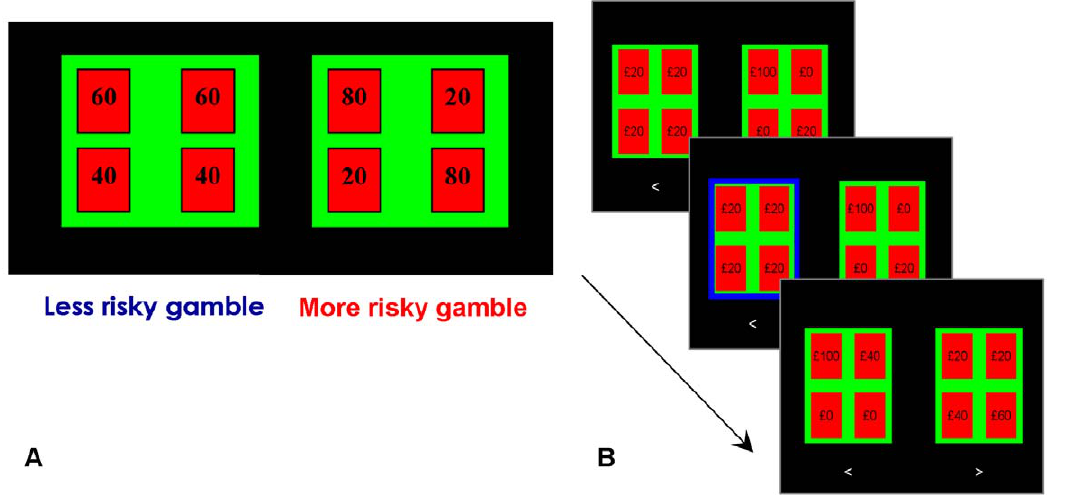
Figure 2. Risk preference task. A. On every trial, a choice between two lotteries was presented on-screen, and subjects were required to select their preferred option from each pair. Lotteries were represented as four cards, with a numerical display of one of six fixed monetary prizes (£0, £20, £40, £60, £80, £100). Each card had an equal chance of being picked. B. The same set of 200 sequential paired lotteries were presented on each visit. Subjects had unlimited time to make a button-press response – the selected lottery was then highlighted on screen with a blue border, before the next trial ensued. No feedback was given about lottery outcomes during the task.